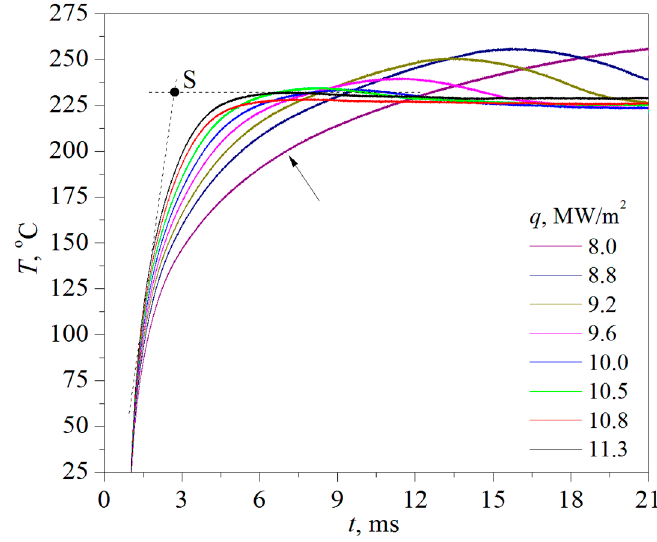
Figure 10. Heating curves for a mixture containing 30 wt.% PPG-425 in the mode of constant power. The experimental parameter is the heat flux density q ( t ) from the heater surface. The arrow points to the temperature curve obtained at q = 8.0 MW/m 2 . The S point is an approximation for the temperature-time conditions that trigger the spinodal decomposition of the unstable system at q = 11.3 MW/m 2